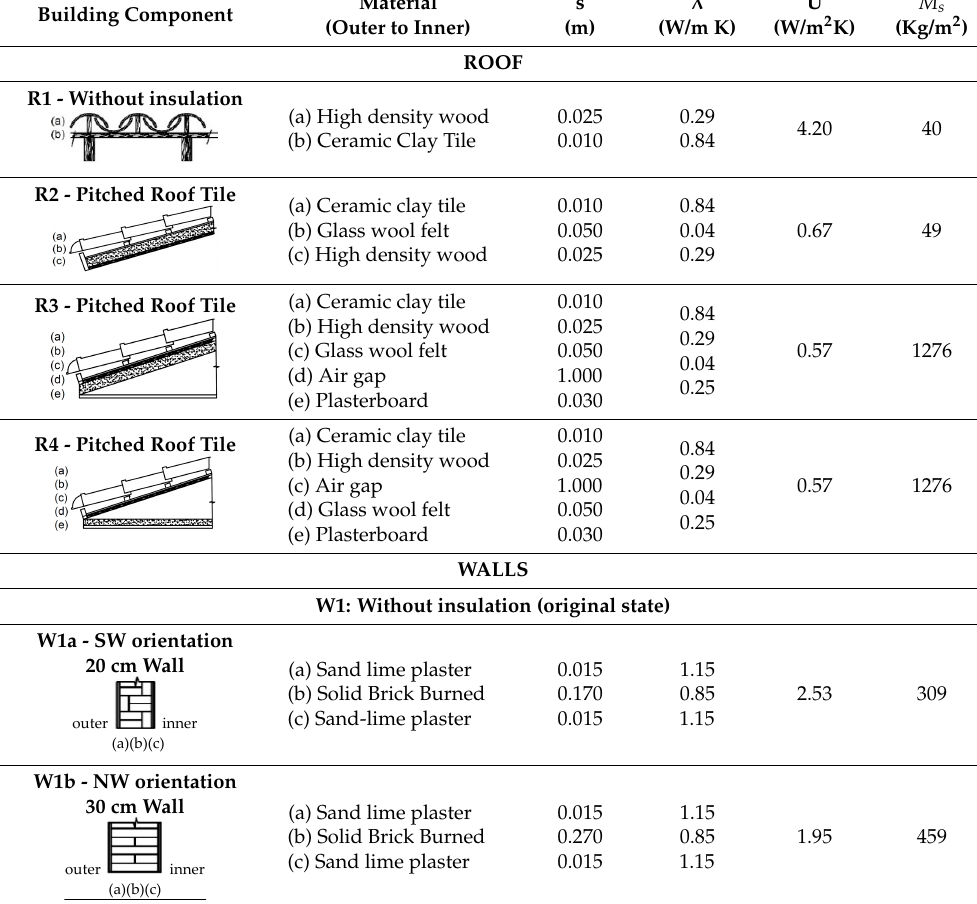
Table 4. Cont. WALLS WALLS W1: Without insulation (original state) W1: Without insulation (original